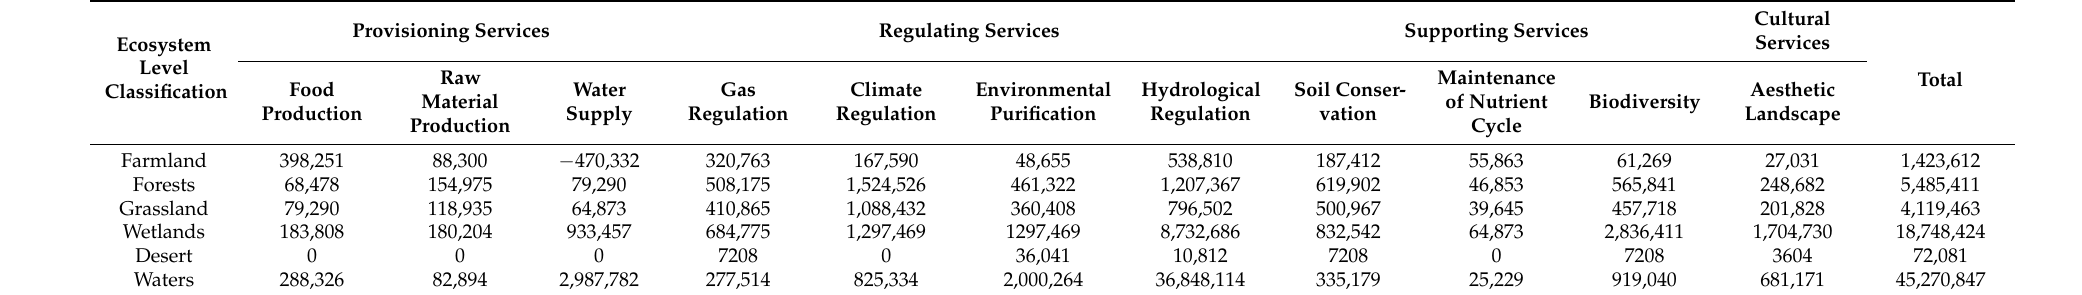
Table 2. Table of ecological service value per unit area of the ecosystem in the Poyang Lake basin level (Yuan/km 2